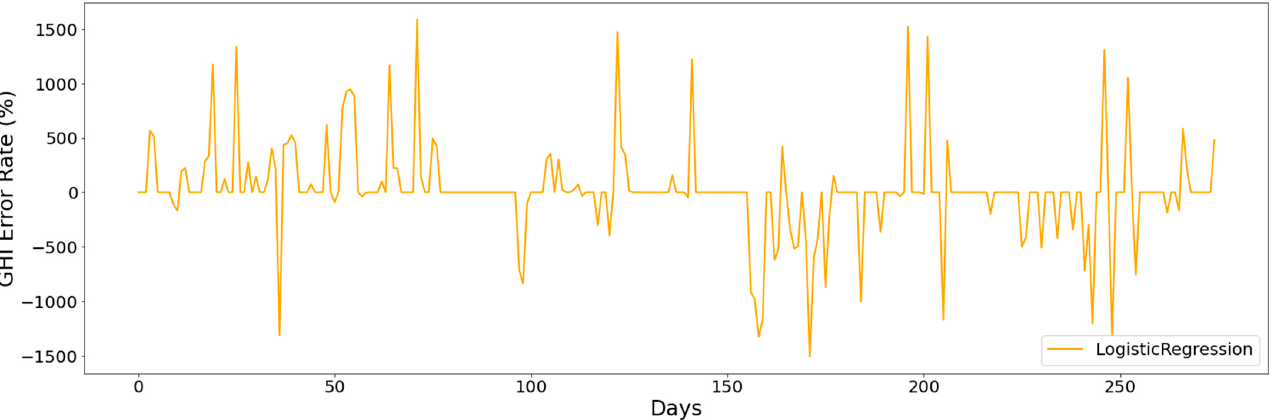
Figure 10. Logistic regression error frequency rate.